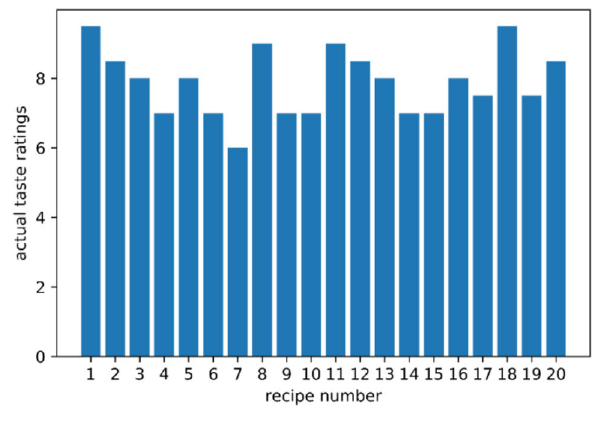
Fig. 3 Actual taste ratings of the